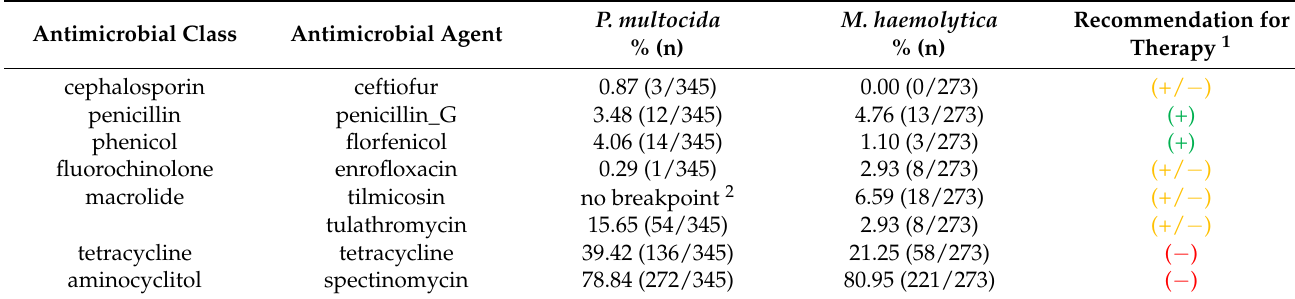
Table 2. Five-year not susceptible rates of bacterial pathogens with defined species-specific breakpoints according to CLSI VET guidelines.